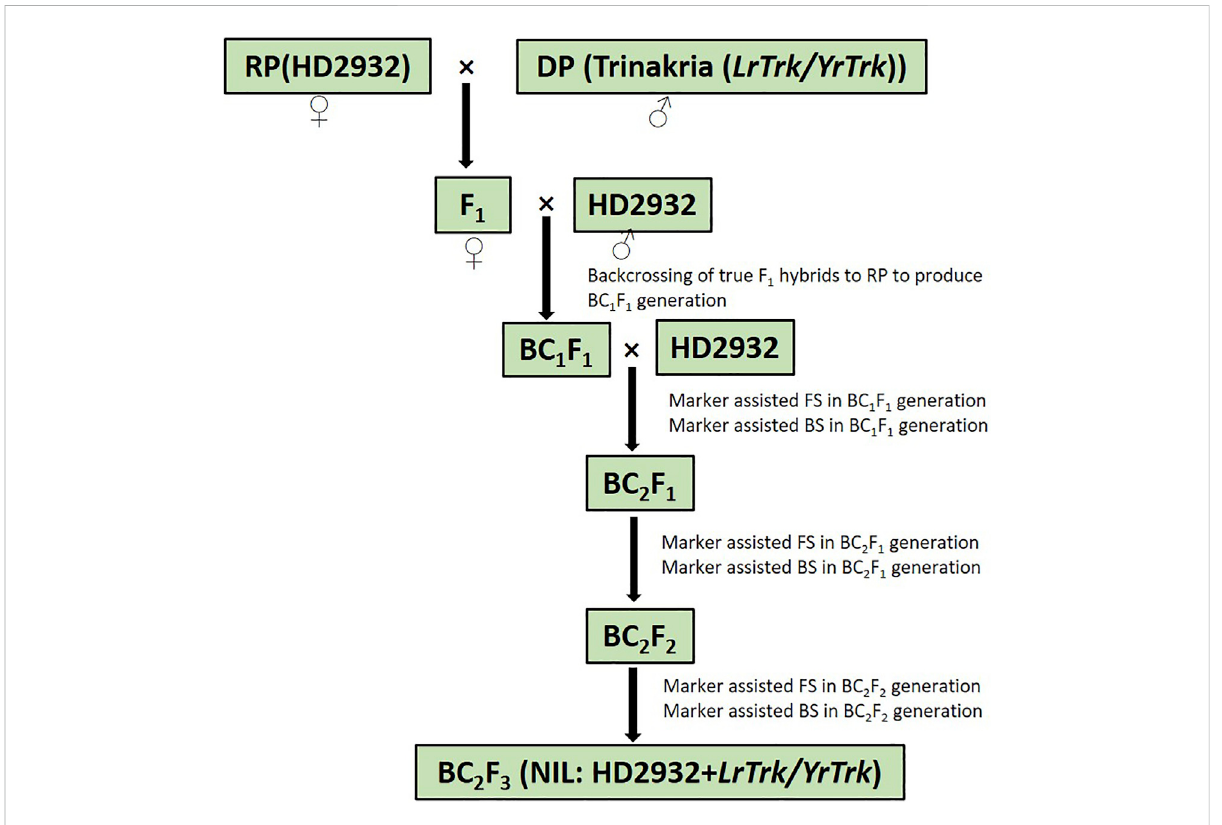
FIGURE 1 Schematic representation of marker-assisted backcrossing to introgress rust resistance gene LrTrk/YrTrk in wheat variety HD2932. RP, recurrent parent; DP, donor parent; FS, foreground selection; BS, background